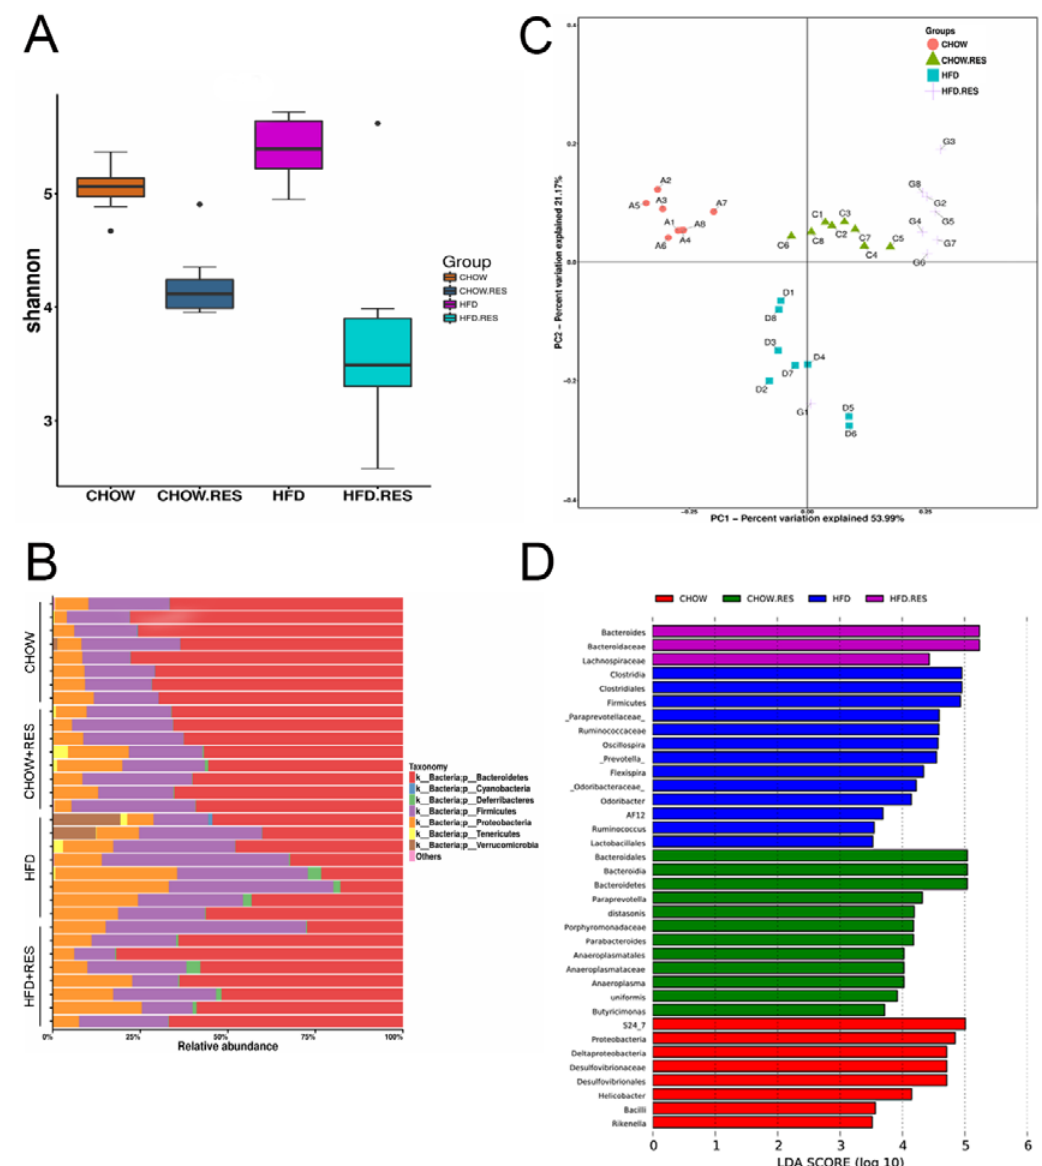
Figure 3. Resveratrol (RES) reversed high-fat diet (HFD)-induced dysbiosis. We performed a 454-pyrosequencing analysis of the bacterial 16S rRNA gene to assess the fecal microbiota composition of the four groups ( n = 8 for each group). The Shannon index ( A ) of the fecal samples from different groups. ( B ) Bar charts showing the relative abundances (%) of different bacterial phyla in the different groups. ( C ) Bacterial communities were clustered using unweighted UniFrac distance-based principal coordinates analysis (PCoA). ( D ) LDA scores of the differentially abundant taxa. Taxa enriched in the gut microbiota from different diet and treatment groups are indicated by the LDA score (taxa with an LDA score > 3.5 and significance of α < 0.05 were determined by the Wilcoxon signed-rank test).